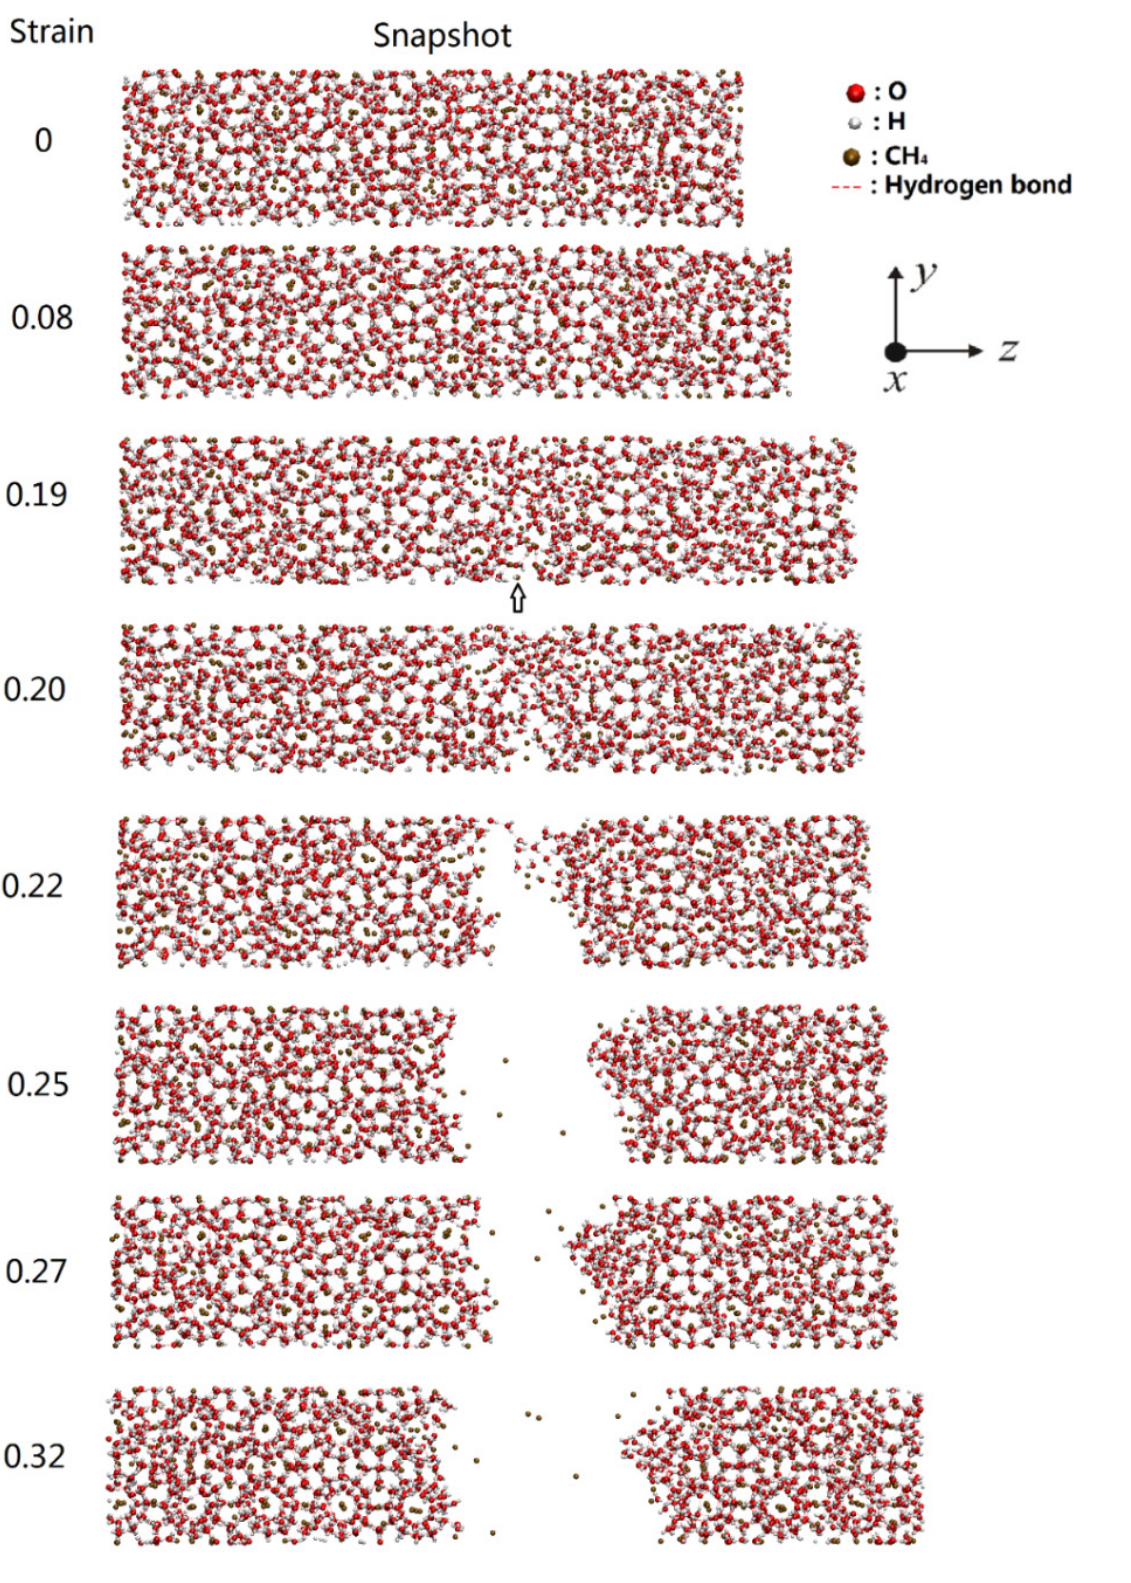
Figure 3 : Snapshots of 2×2×8 unit cells during